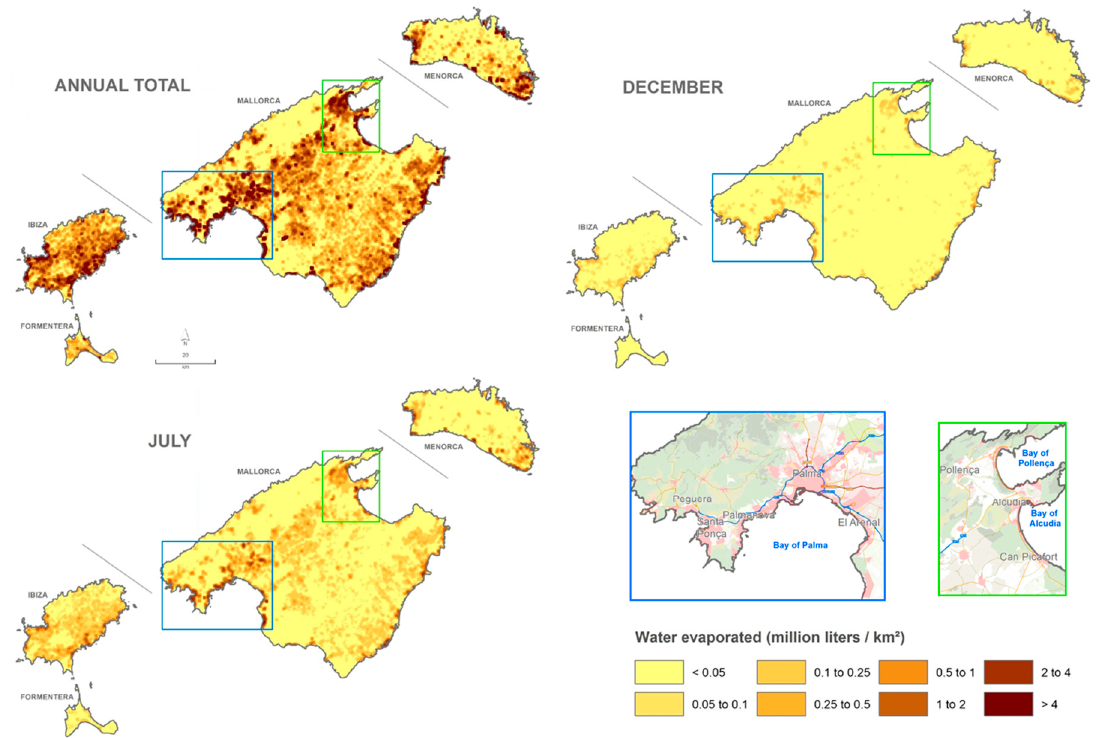
Figure 7. Spatial pattern of the water volumes evaporated from swimming pools in the Balearic Islands (2006–2015 average): annual ( top left ), July (annual max., bottom left ) and December (annual min., top right ). Table 1. Evaporative water loss from swimming pools in the Balearic Islands (million L).